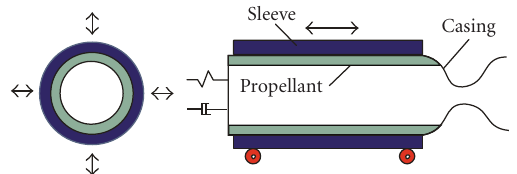
Figure 1: Cylindrical-grain SRM schematic model setup for static test stand firing in a laboratory.